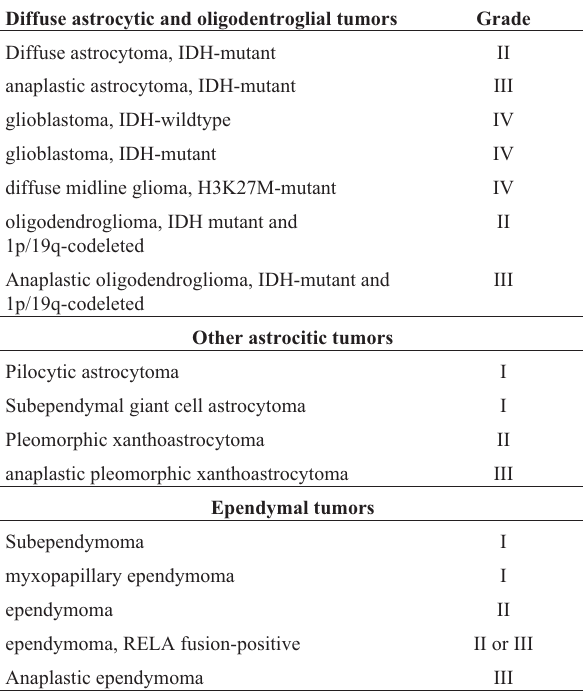
Table 1 - WHO 2016 types and grade of